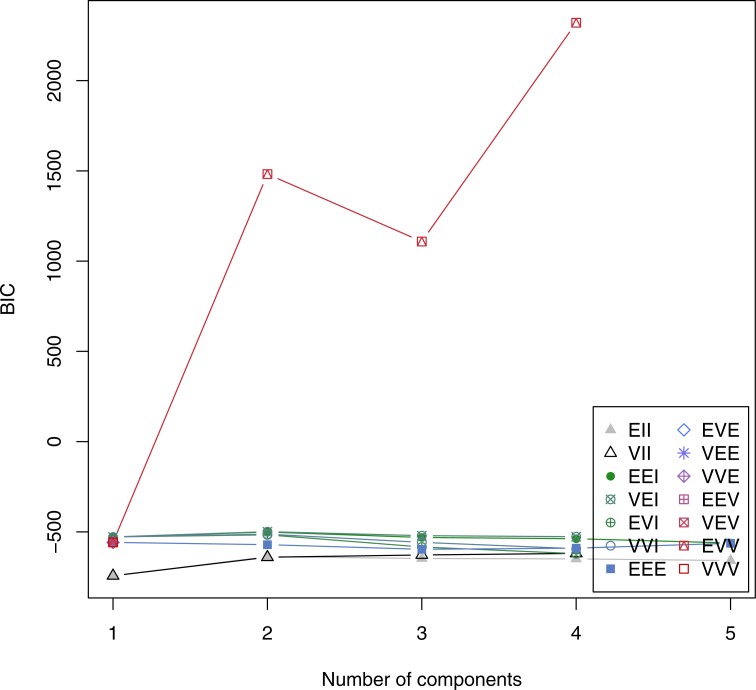
MClust analysis for testing different probability models.